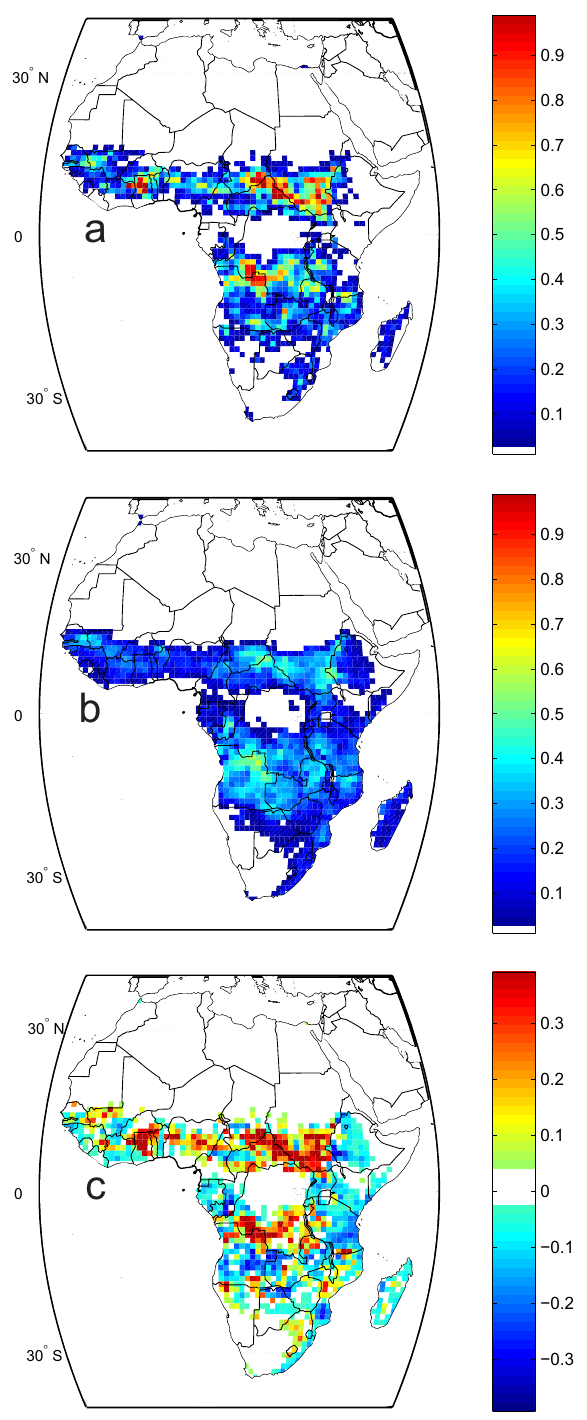
Fig. 4. Fraction of area burned in the fire year 2007. Panel (a) remotely sensed from MODIS MCD45; panel (b) predicted from the parameterised fire model VC. Panel (c) residuals observed – predicted from model VC. Data for the year 2007 is not used for the estimation of the model parameters (Table